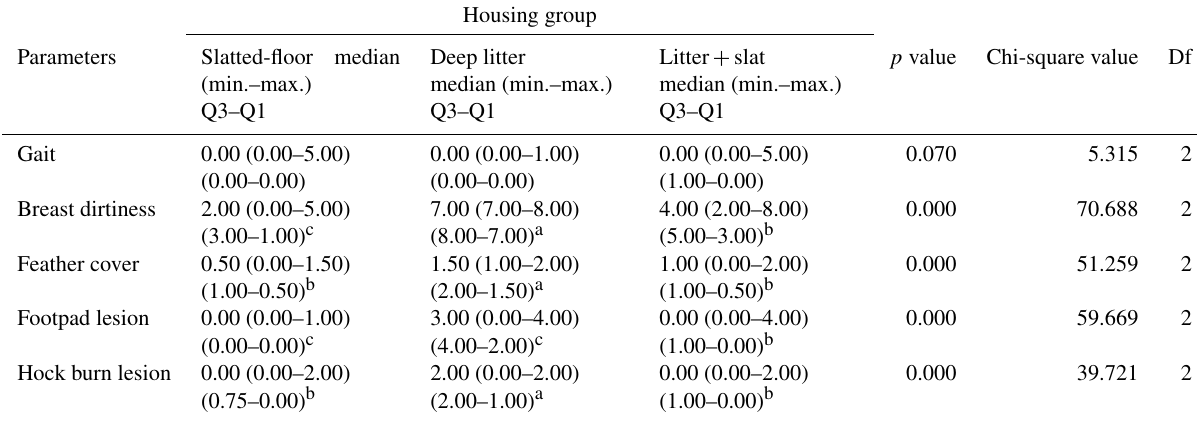
Table 2. Summary statistics of gait, breast dirtiness, feather cover, and footpad and hock joint lesion scores in the experiment. Df is degrees of freedom.